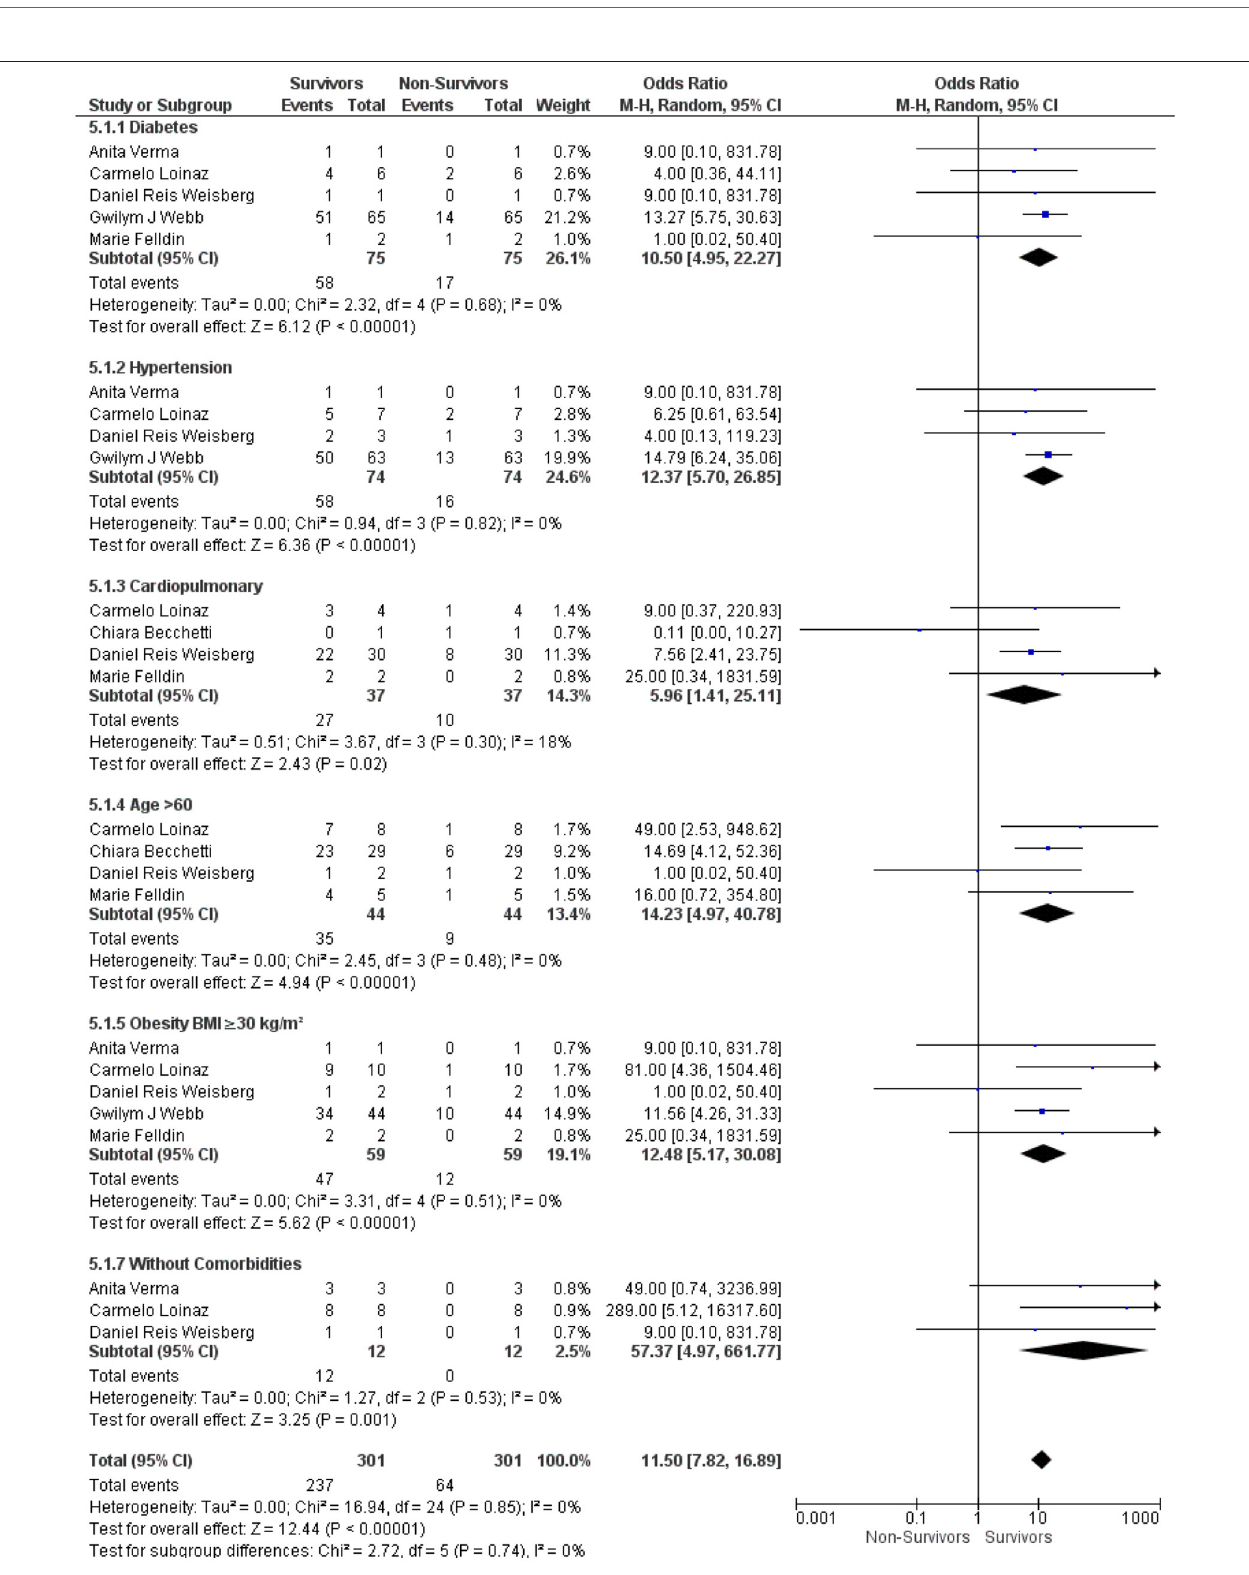
FIGURE 5 | Forest plots for an association between the survivors and non-survivors LT recipients with COVID-19 based on comorbidities under an immunosuppressive therapy.